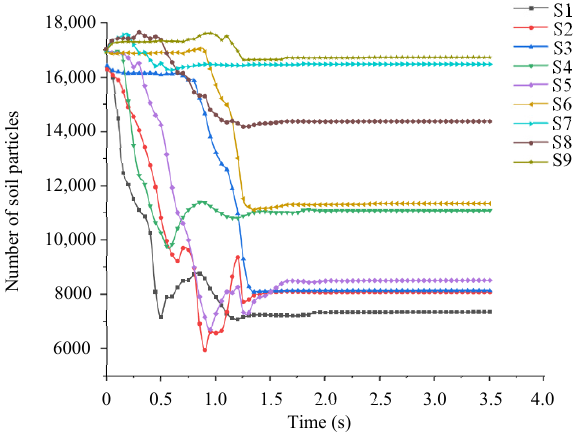
Figure 10. Variation of particle number in different zones during rotary tillage.